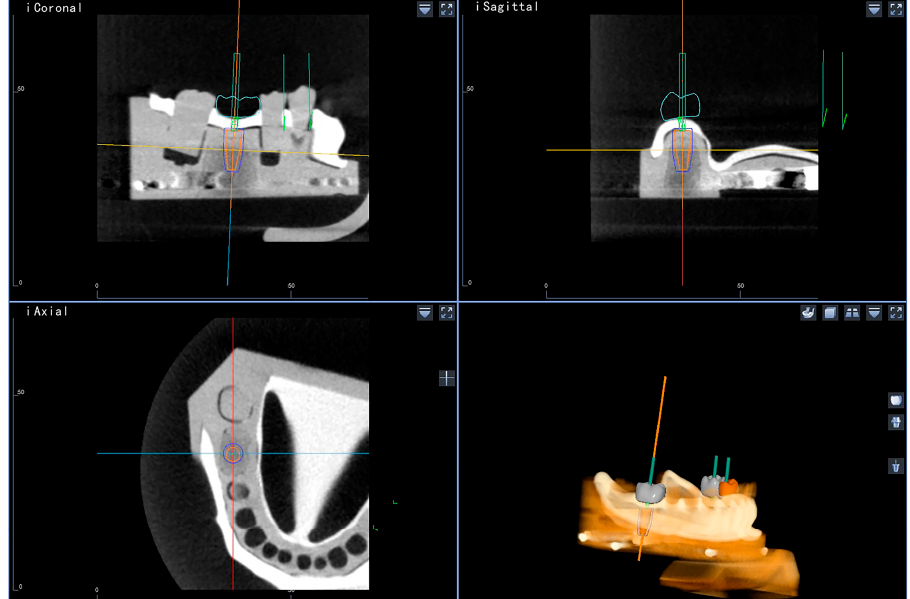
Figure 2. Preoperative treatment plan created by the dynamic navigation software.